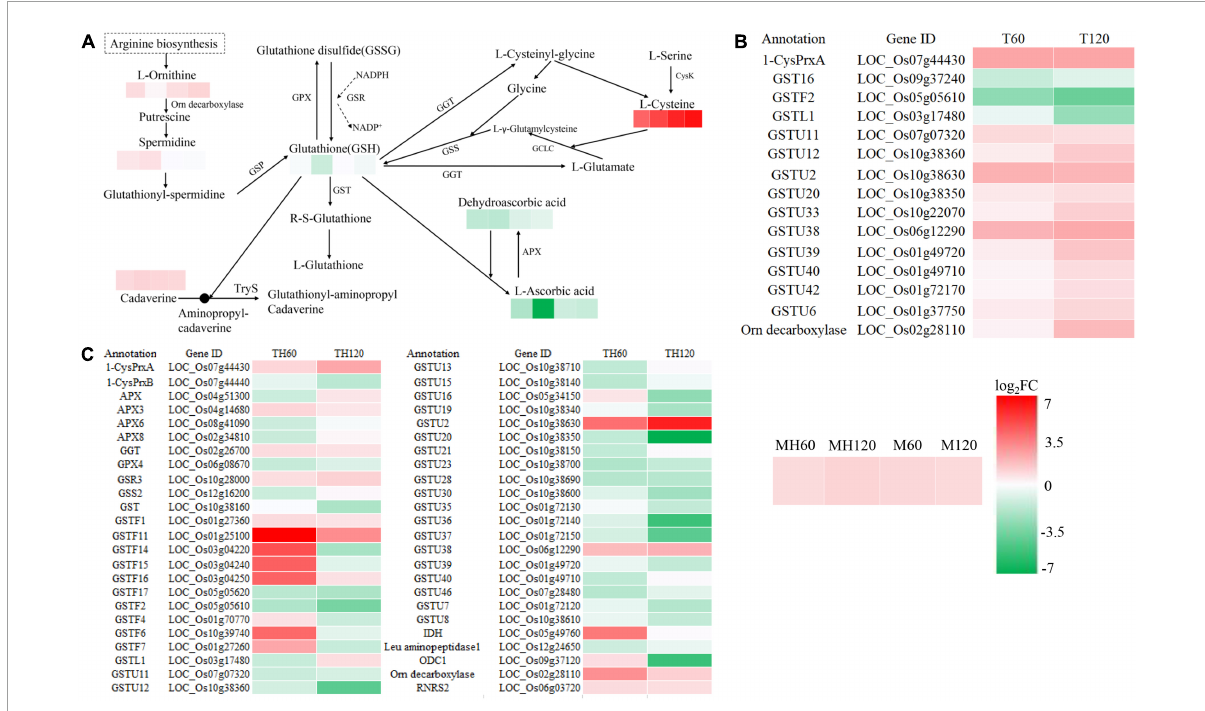
FIGURE9 Analysis of DEGs and SRMs in the glutathione metabolic pathway. (A) The enriched SRMs of MH60, MH120, M60, and M120 in the glutathione metabolic pathway. Spermidine, GSH, and dehydroascorbic acid were not SRMs in the M60 and M120. (B) The enriched DEGs of T60 and T120 in the glutathione metabolic pathway. (C) The enriched DEGs of TH60 and TH120 in the glutathione metabolic pathway. |log 2 FC| denotes |log 2 fold